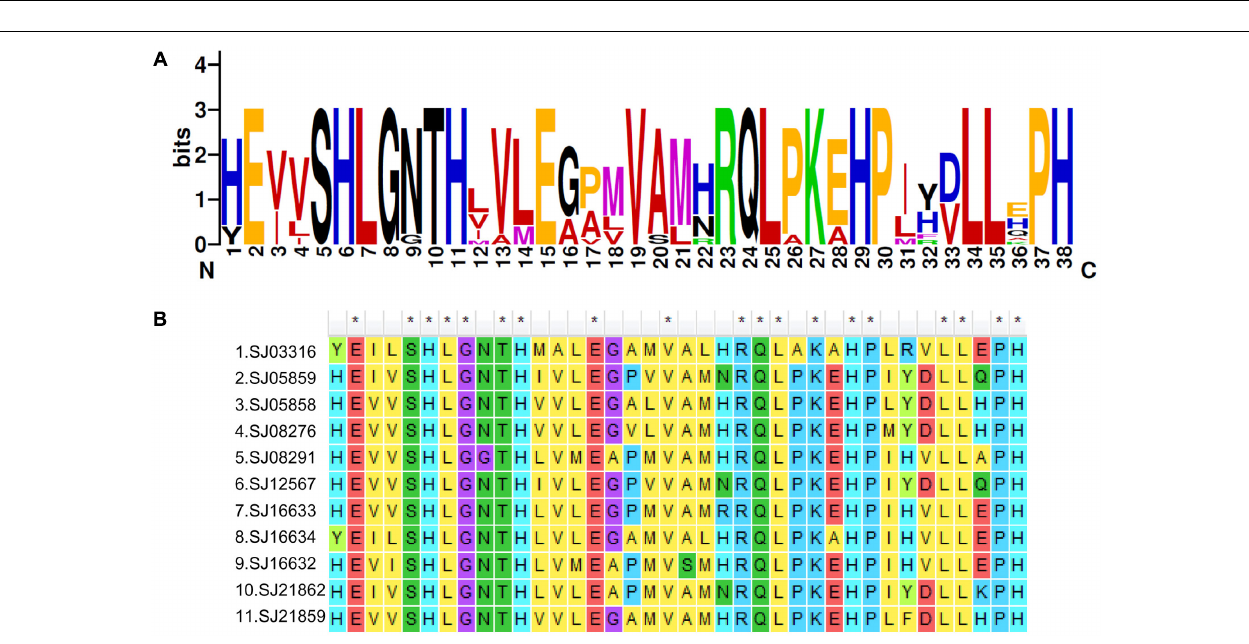
FIGURE 4 | Schematic representation of the conserved motifs in brown algal LOX proteins. Each colored box represents a motif in the protein, with the motif number indicated in the middle of the box. The length of the protein and motif can be estimated using the scale at the bottom.